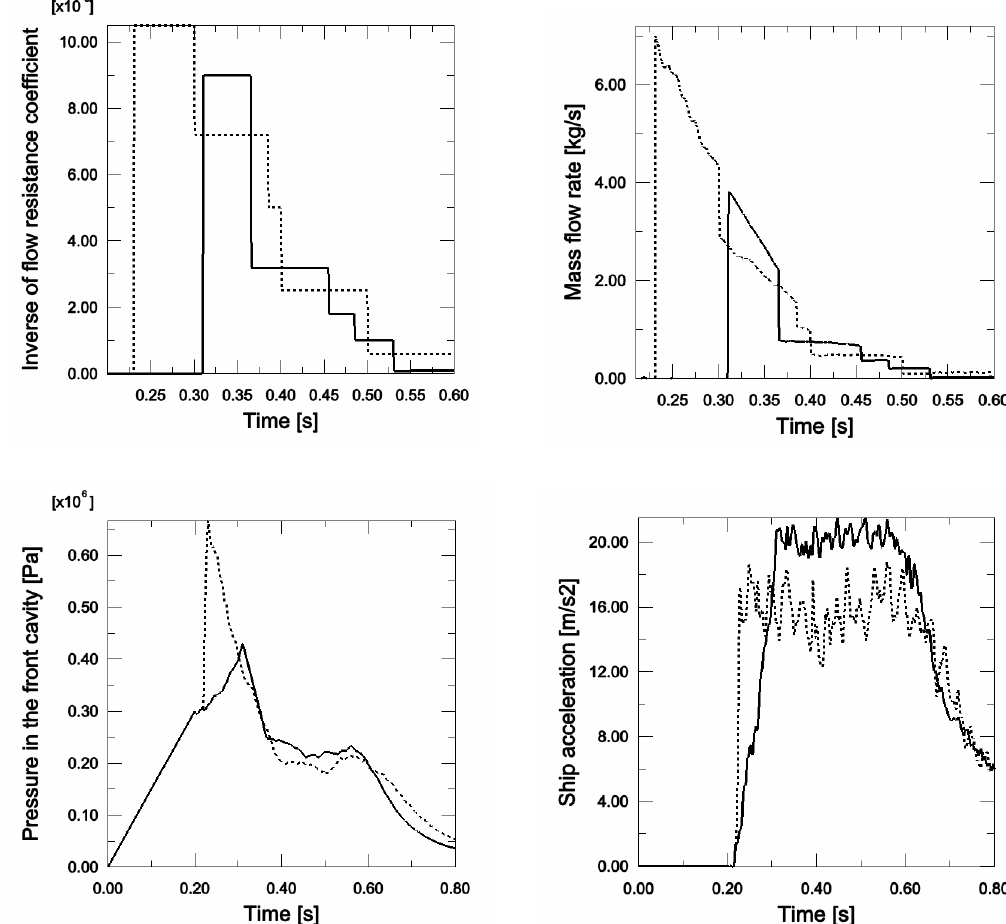
Fig. 8. Two strategies of active acceleration mitigation: a) pressure only released during impact (continuous line), b) additional inflation at the beginning of impact (dashed line). not completely reduced, but final chamber volume is minimal and work that can be done by gas is relatively